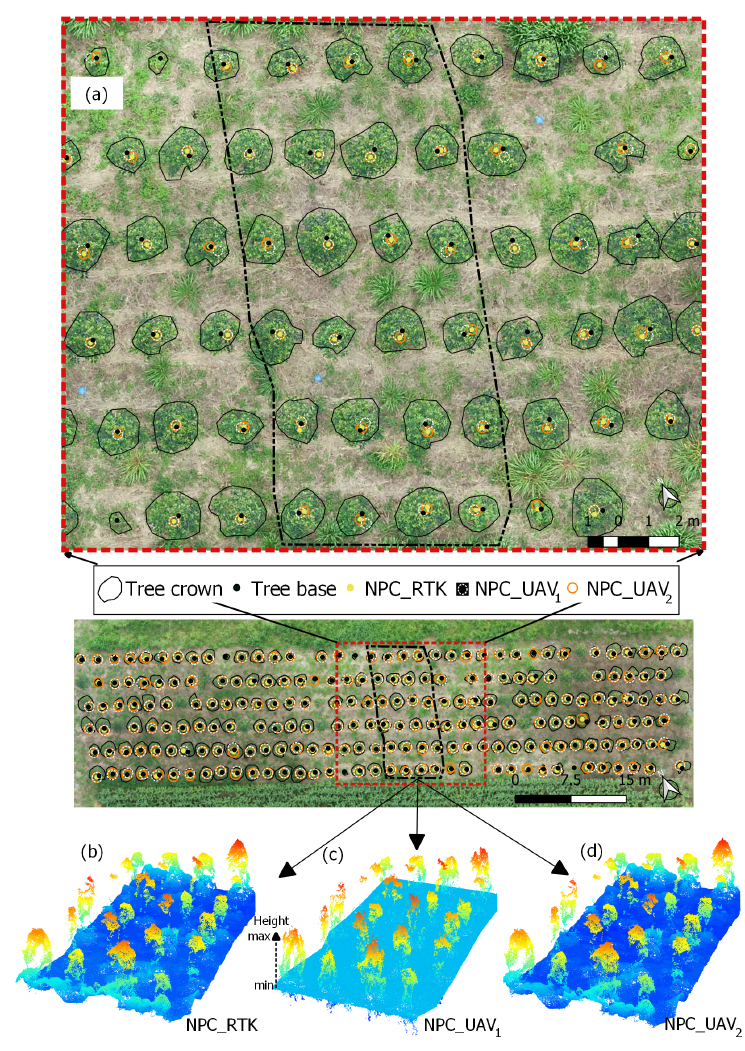
Figure 3. ( a ) RGB orthomosaic of a young Eucalyptus stand indicating tree crowns mapped through visual interpretation (black outlined polygons), tree bases obtained in the field with RTK (black dots), and three tops detected with three different normalized point clouds: ( b ) NPC_RTK (yellow dots), ( c ) NPC_UAV 1 (white circles), and ( d ) NPC_UAV 2 (orange